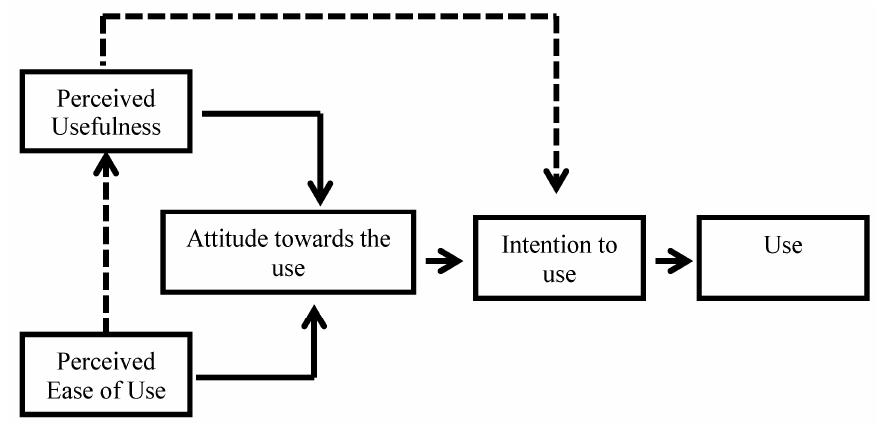
Figure 2. Basic TAM model [18].